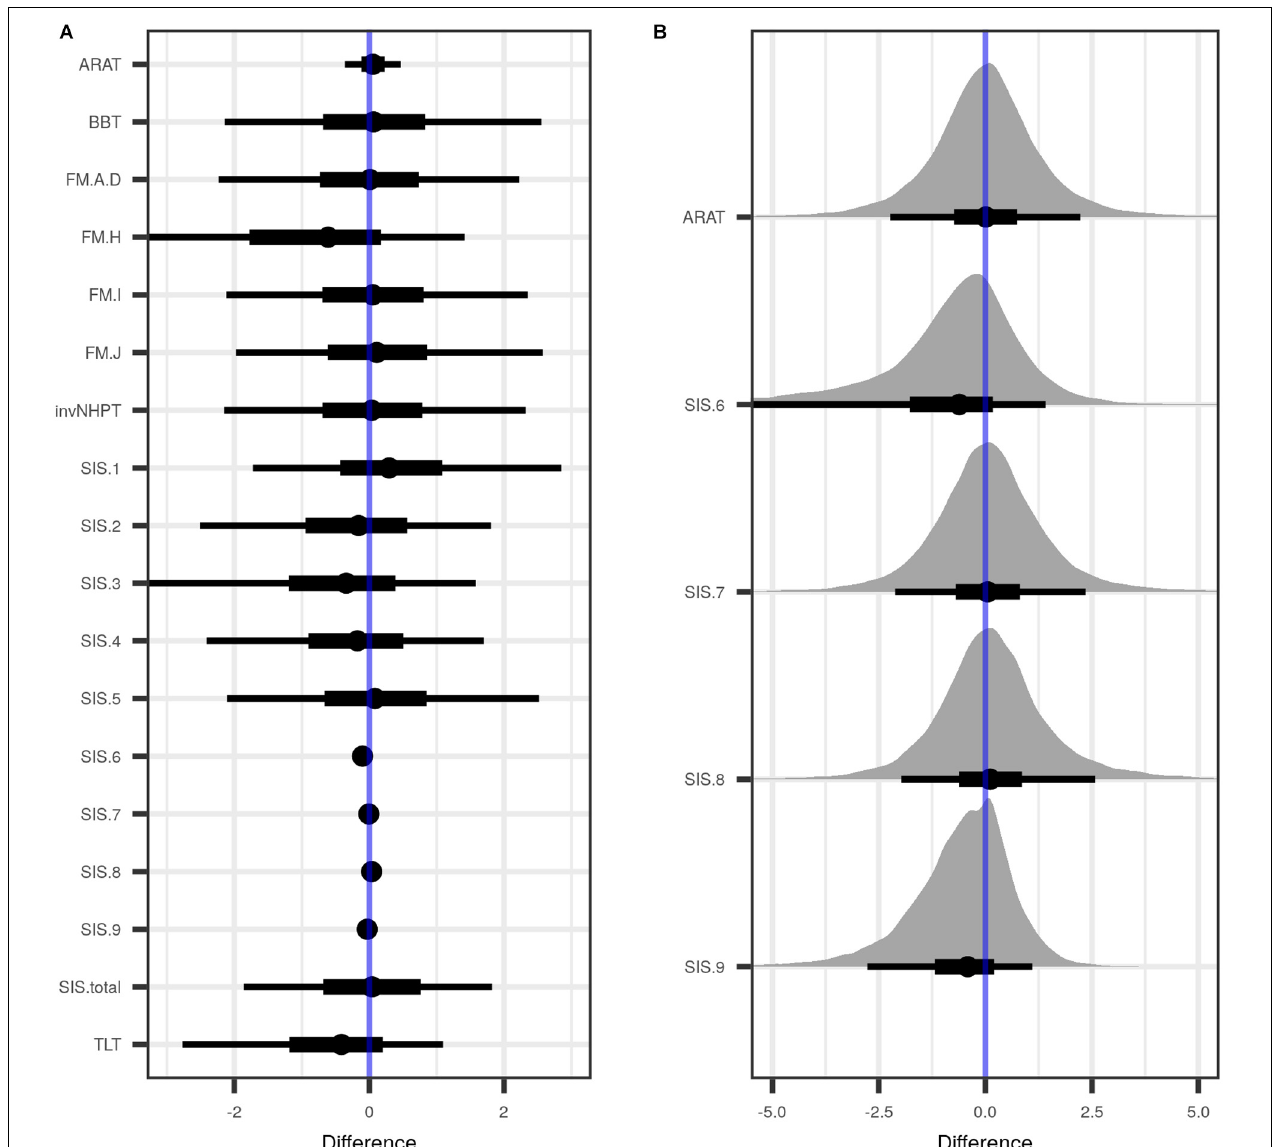
FIGURE 3 | Estimated differences between treatment and control group, when data from both sites were combined and pre-treatment values were taken into account. (A) Shown are the posterior distributions of differences between treatment and control groups of the tested variables, with median point estimate (dot), 50 percent uncertainty interval (thick black horizontal bar), and 90 percent uncertainty interval (thin black horizontal bar). (B) A close-up of those variables in A with a point estimate close to zero. ARAT, Action Research Arm Test; BBT, Box and Block Test; FM.A-D, Fugl-Meyer test subscales A–D, covering reflexes, volitional movements, wrist and hand function and the coordination of the upper extremity; FM.H, tactile sensation in the affected and non-affected extremity; FM.I, passive joint motion; FM.J, passive movement joint pain; invNHPT, (inverted) Nine-Hole Peg Test; SIS.1 (Stroke Impact Scale, subscale 1), physical problems as a result